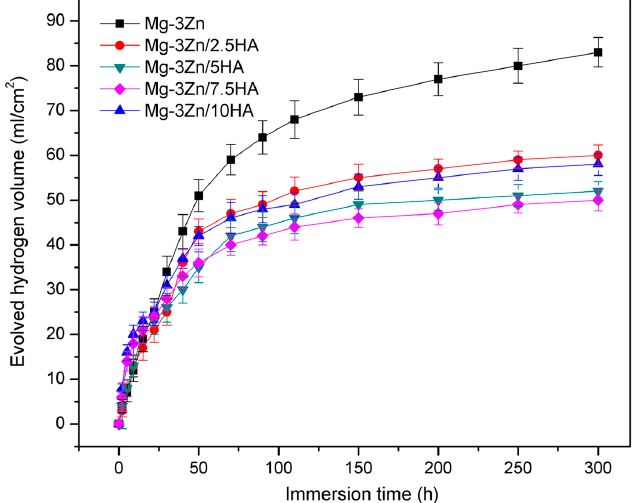
Figure 6. The evolved hydrogen volume of the Mg-3Zn/ x HA composites immersed in SBF solution at 37 ± 0.5 °C.